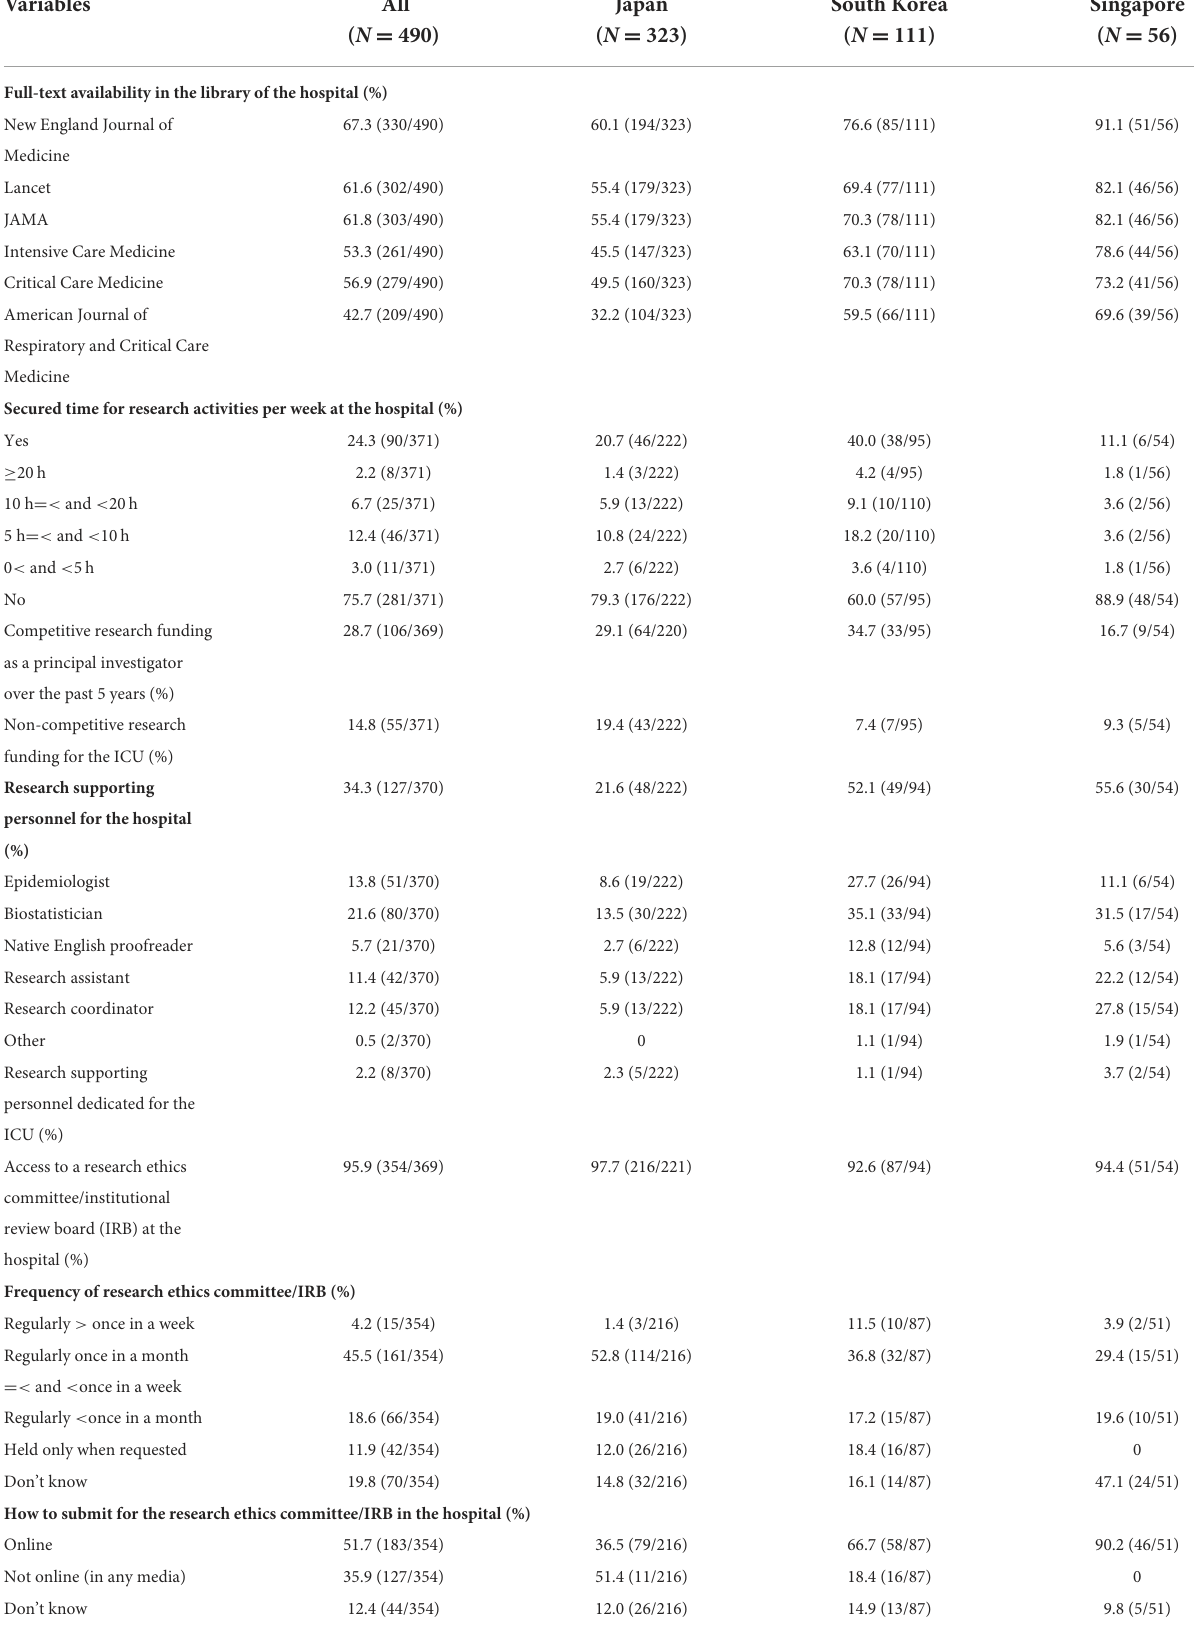
TABLE 2 Factors related to research environment of the